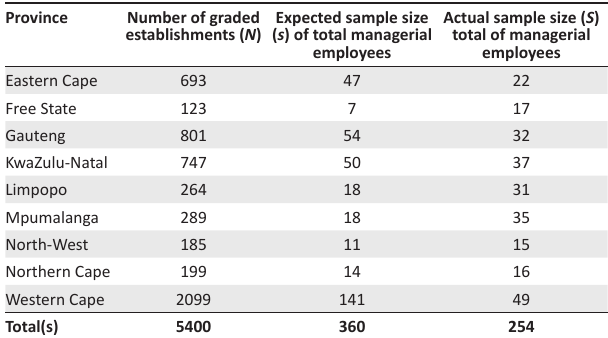
TABLE 3: Profile of the